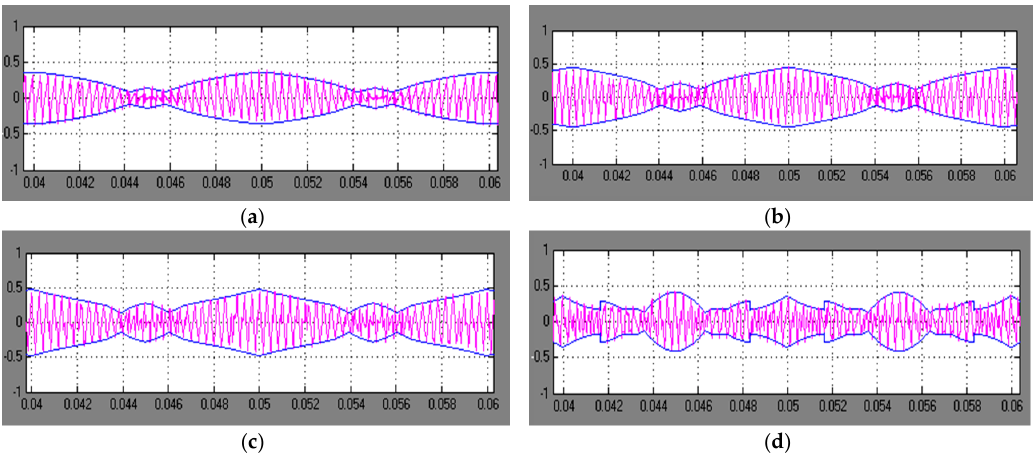
Figure 26. Experimental current ripple and theoretical envelope in the case of DPWM3 for: ( a ) m = 1/6; ( b ) m = 1/4; ( c ) m = 1/3; and ( d ) m = 1/2.